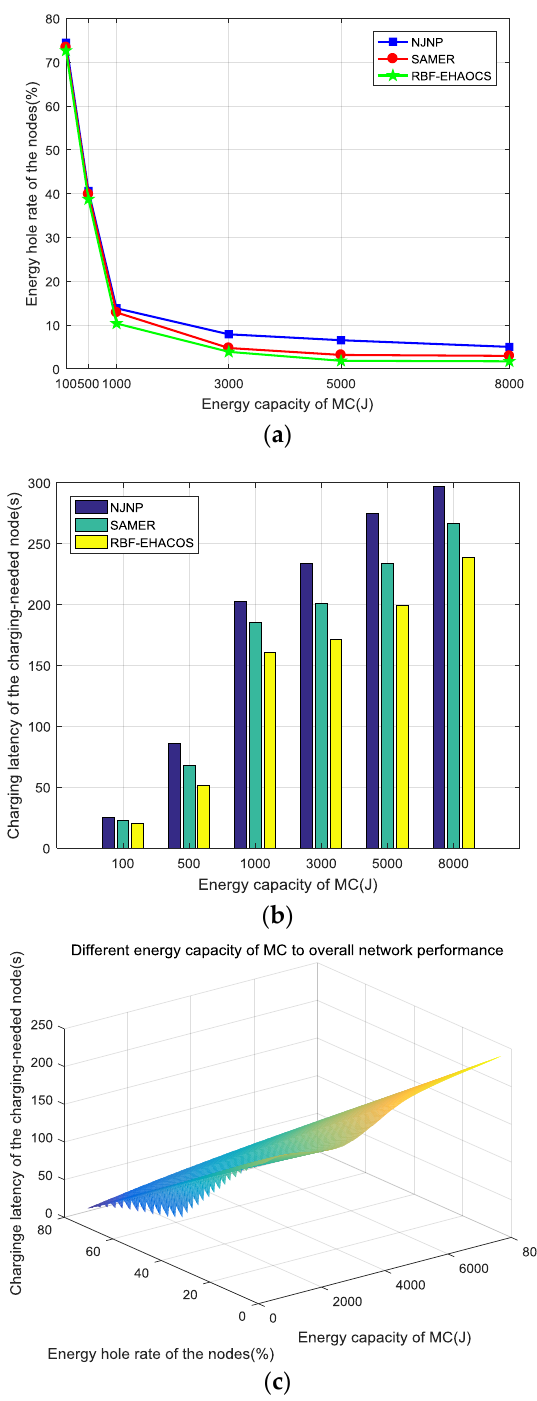
Figure 8. ( a ) Energy hole rate of the nodes, ( b ) charging latency of the charging-needed node, and ( c ) overall network performance. overall network